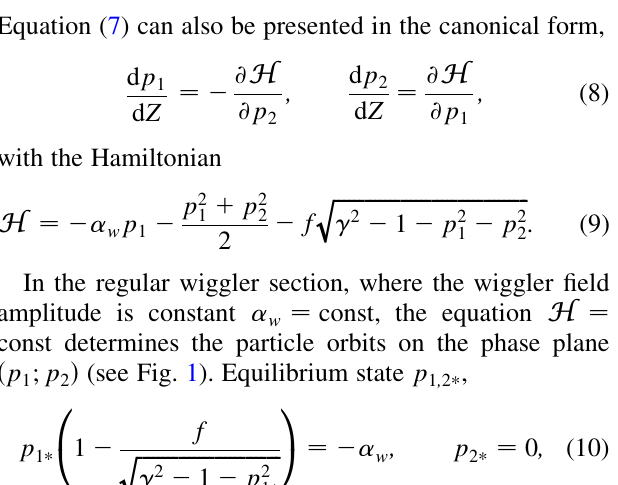
Þ at the ; p 1 2 and cr